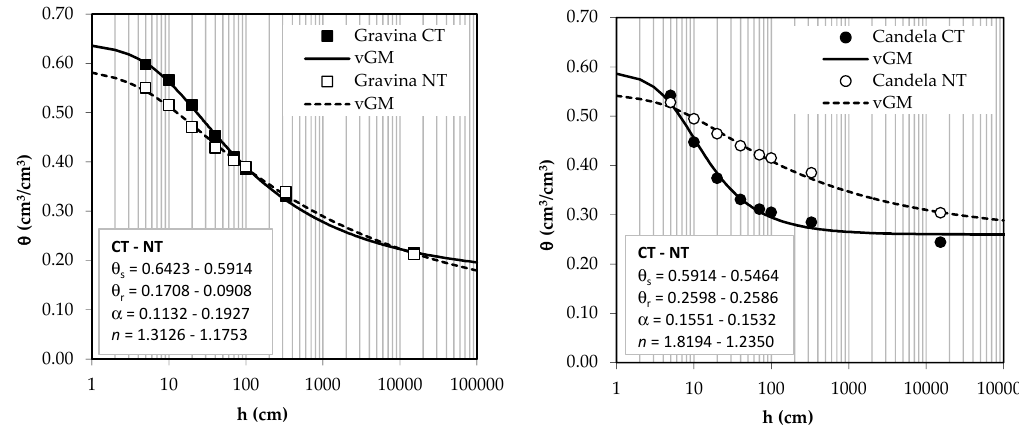
Figure 8. Normalized pore volume distributions and the corresponding modal diameters (d mod ) of the four site–soil management combinations (G, Gravina; C, Candela; CT, conventional tillage; NT, no- tillage), calculated according to Reynolds et al. [62]. In accordance with the literature assessing optimal physical conditions of agricultural soils (Table 1), a better soil physical quality was observed for Gravina rather than for Candela, since optimal values of macroporosity, air capacity, and relative field capacity, as well as good levels of plant available water, were always detected both under CT and NT (Table 6). Conversely, the Candela site showed some discrepancies between soil management as nonoptimal soil conditions